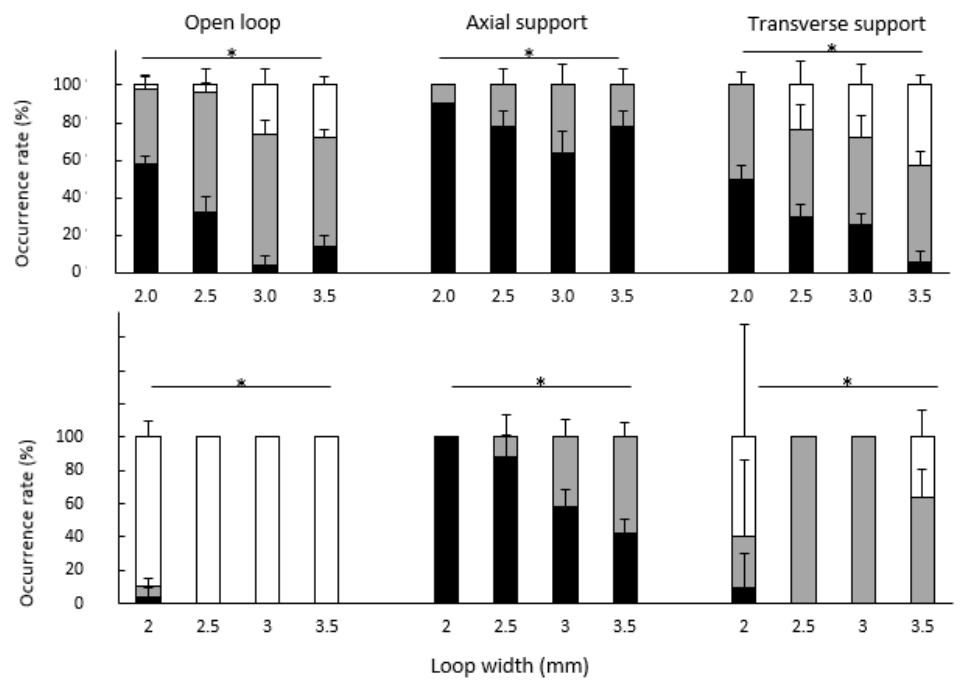
Figure 5. Occurrence rate of vitrification outcomes for different support configurations and loop widths of VDCV held horizontally ( upper ) and vertically ( bottom ). Error bars represent the standard deviation. Asterisks indicate significant differences in full vitrification among different loops widths.